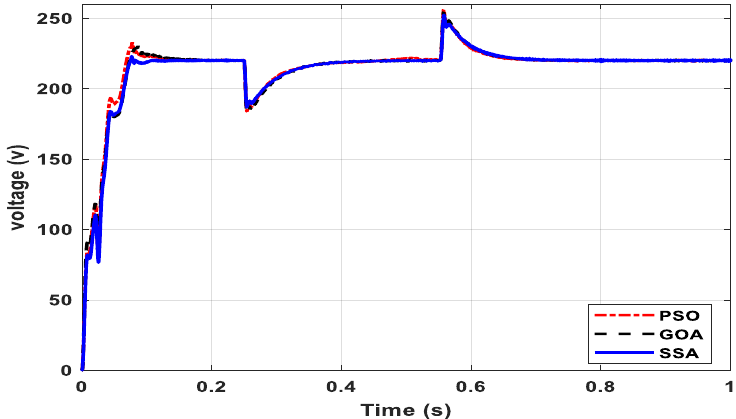
Figure 6. The voltage response of the system during DG insertion and load change.